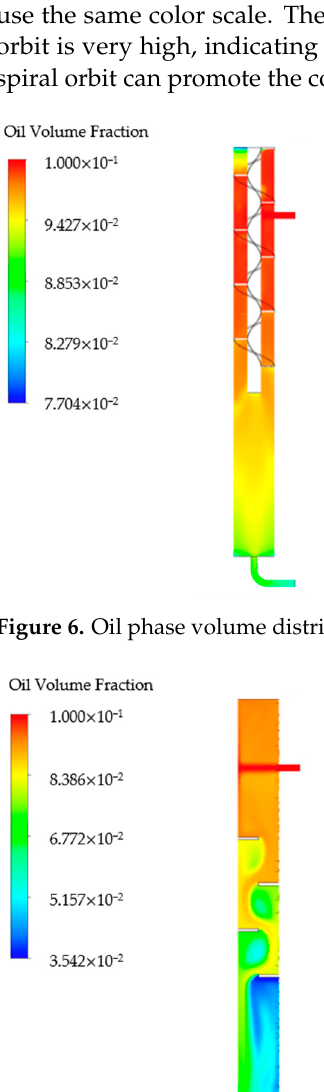
Figure 7. Oil phase volume distribution of semicircular